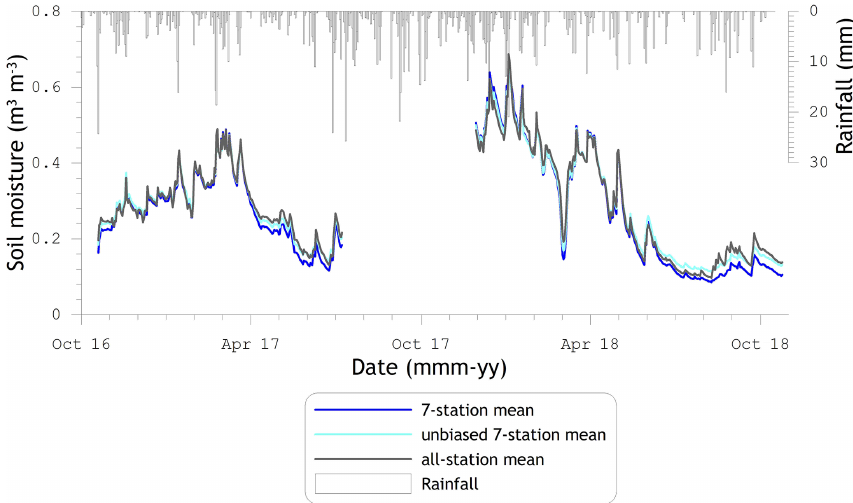
Figure 4. Spatial soil moisture means for SMAP reference pixels 3306 and 3606 from October 2016 up to October 2018.